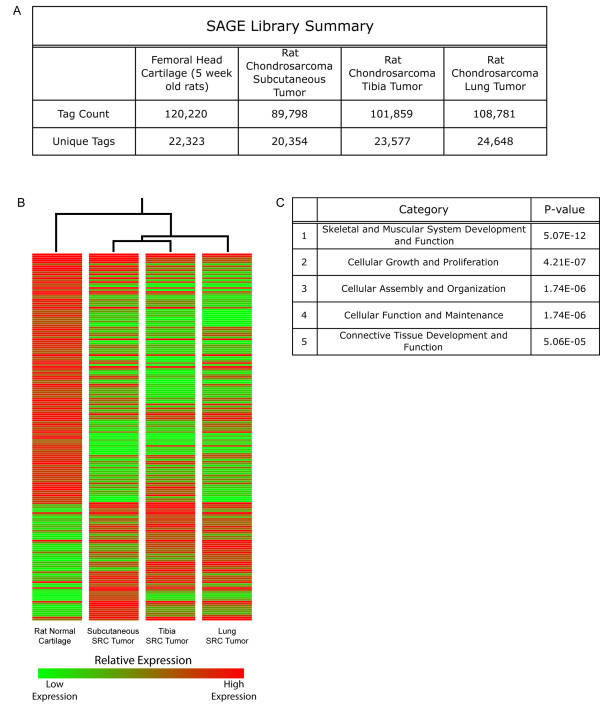
Summary and analyses of SAGE libraries. (A) Summary of SAGE tags generated from normal cartilage and the SRC tumors. The total number of SAGE tags and the number of unique tags are listed for each SAGE library. (B) Heat map displaying the differentially expressed genes between RNC and SRC tumor tissues. Rat normal (articular) cartilage has a unique expression profile when compared to the expression profiles of the SRC tumors. The changes in gene expression may represent critical differences between normal cartilage cells and chondrosarcoma, and they may also represent changes important for the development and progression of chondrosarcoma. Heat map displays the differentially expressed genes that were expressed at a level of at least 25 tags in one library. For complete gene list see Additional file 2. Color bar illustrates relative gene expression levels. (C) The list of differentially expressed genes was analyzed with the pathway-mapping program Ingenuity. The top five functional pathways and their corresponding p-values are displayed in table (see “Methods” for description of p-value).